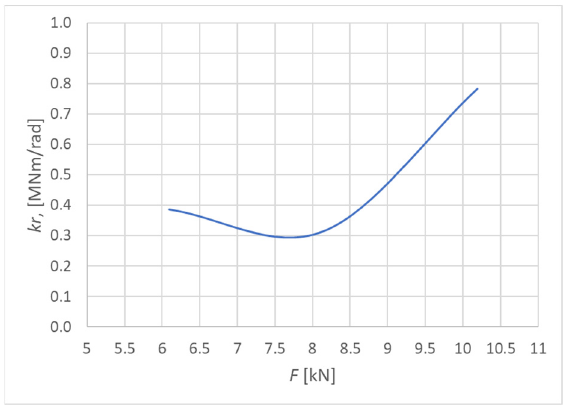
Figure 21. Trend of rotational stiffness for Experiment B.